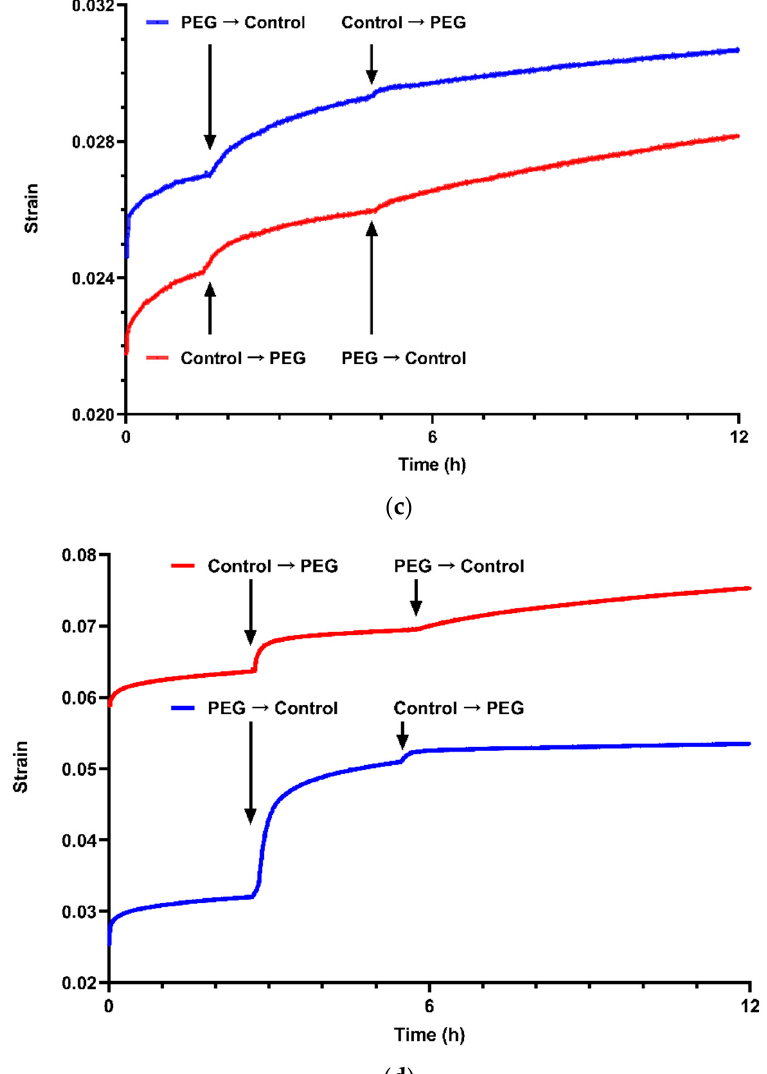
Figure 1. Effects of exchanging MES buffer for the same buffer containing PEG and the opposite exchanges, altering the osmotic potential from 0 MPa to − 0.62 MPa or from − 0.62 MPa to 0 MPa ( a ) and ( b ) on extension of cell walls from sunflower hypocotyls, ( c ) on bacterial cellulose and ( d ) on bacterial cellulose composite with pectin and xyloglucan. Arrows indicate the times at which osmotic potential was increased or reduced. Strain = Ln(L t /L 0 ), where L t = length at time t and L 0 = length at plot time zero (these were lengths immediately before load was increased in plots ( a ), ( c ) and ( d ) and lengths 12 min before buffers were exchanged in ( b ). ( a ) Sunflower hypocotyls extending under an applied load of 0.196 N (applied at 0 h). Blue: 0 MPa → − 0.62 MPa; Red: − 0.62 MPa → 0 MPa. ( b ) Detail of data in Figure 1a illustrating changes in strain immediately after increasing or decreasing water potential. Blue: 0 MPa → − 0.62 MPa; Red: − 0.62 MPa → 0 MPa. ( c ) Strips of bacterial cellulose extending under an applied load of 0.196 N (applied at 0 h). Blue: − 0.62 MPa → 0 MPa → − 0.62 MPa; Red: 0 MPa → − 0.62 MPa → 0 MPa. ( d ) Strips of bacterial cellulose composite with pectin and xyloglucan extending under an applied load of 0.098 N (applied at 0 h). Blue: − 0.62 MPa → 0 MPa → − 0.62 MPa; Red: 0 MPa → − 0.62 MPa → 0 MPa. Sample data from similar experiments using bacterial cellulose and bacterial cellu- lose composite with apple pectin and tamarind xyloglucan (CPX) are shown in Figure 1c,d Although the bacterial cellulose was much less extensible than the sunflower walls, respectively. In these experiments the buffers were exchanged twice so that either the con- and the changes in rate of extension are therefore less clear than in the plant cell wall trol buffer was replaced with buffer containing PEG for a period before returning the material, the same broad effect of water content was strips to the control buffer or the buffer containing PEG was replaced for a period with